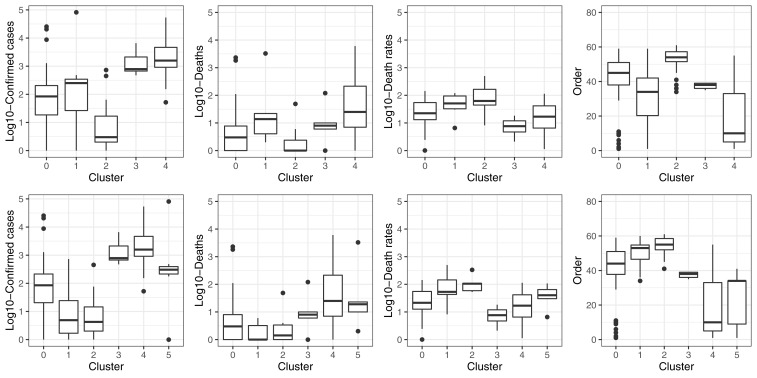
Boxplots showing the distribution of COVID-19 pandemic variables across clusters.